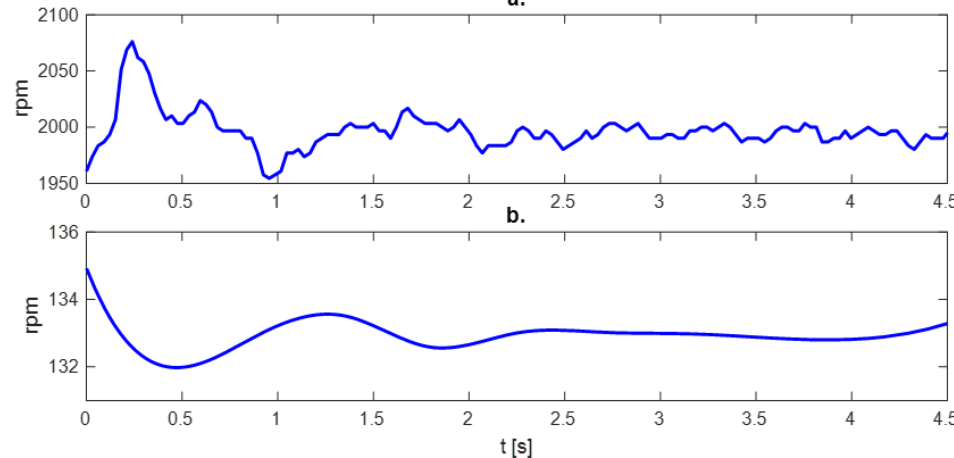
Figure 6. Fluctuation of ( a ) input and ( b ) output shaft rotational speed.